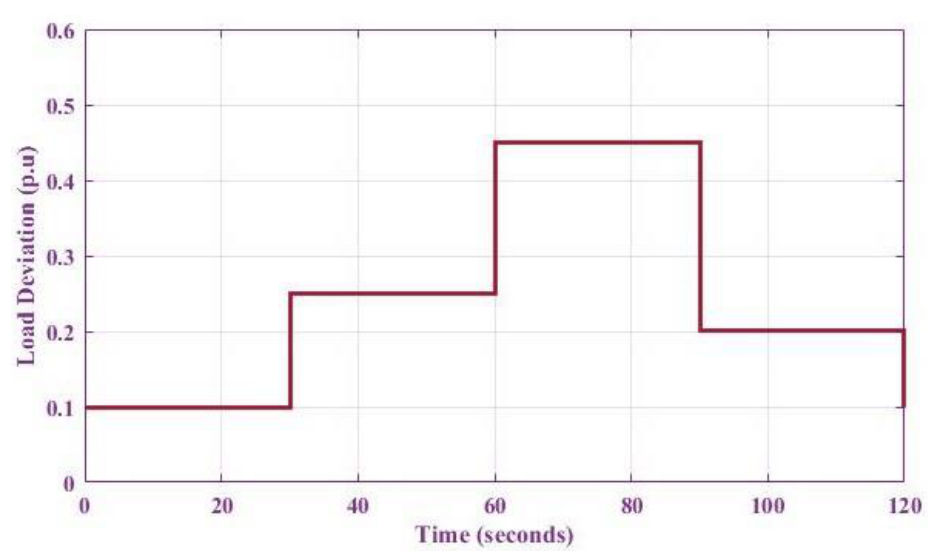
Figure 12. Abrupt load deviation presentation.